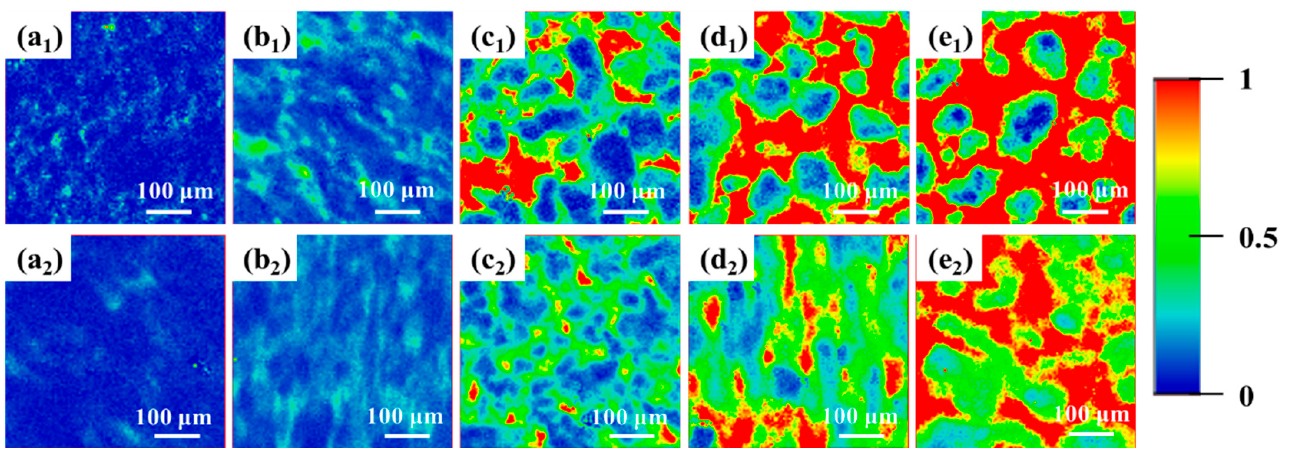
Figure 2. Raman mapping of ratio of the peak intensities (I 804 /I 1295 ) for UHMWPE/PP: ( a ) 95/5, ( b ) 85/15, ( c ) 75/25, ( d ) 65/35, ( e ) 50/50; 1 and 2 stand for the UHMWPE/PP prepared by shear flow and elongational flow, respectively.